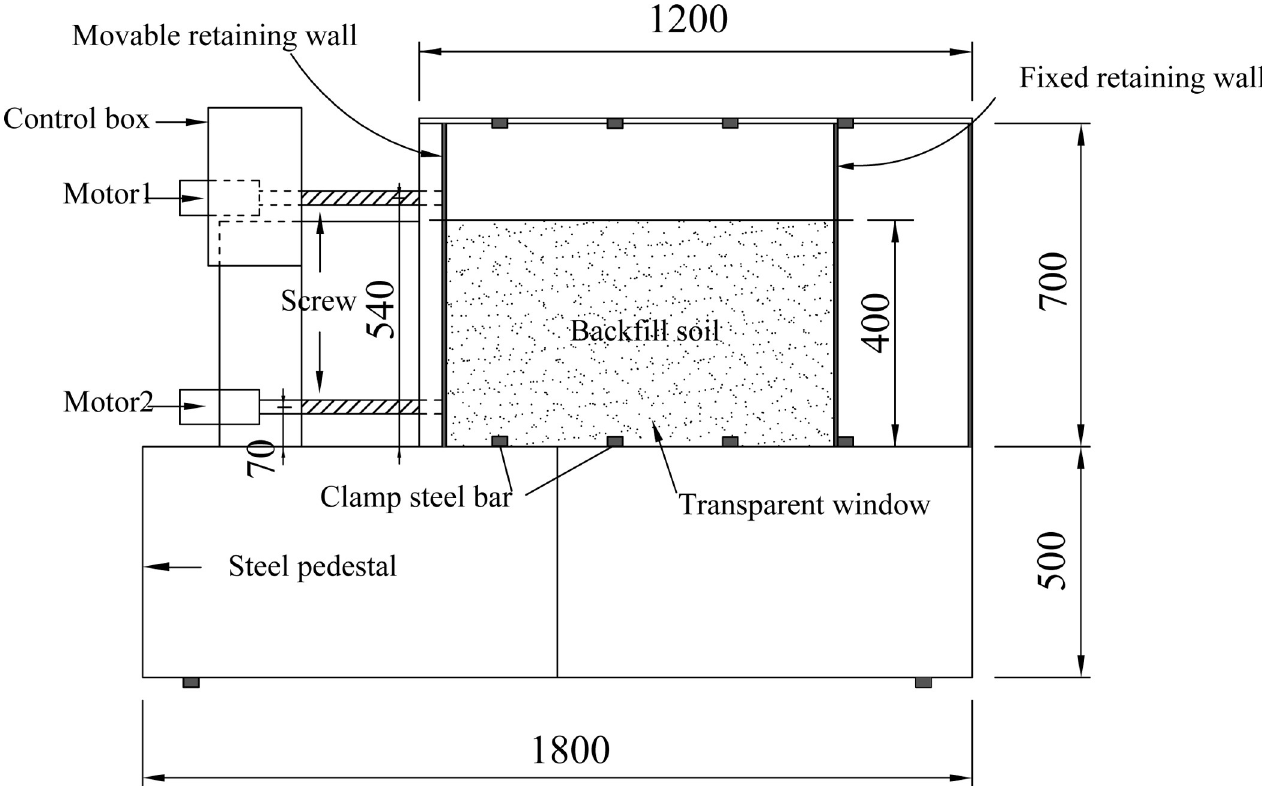
Fig 1. Test model box (unit: